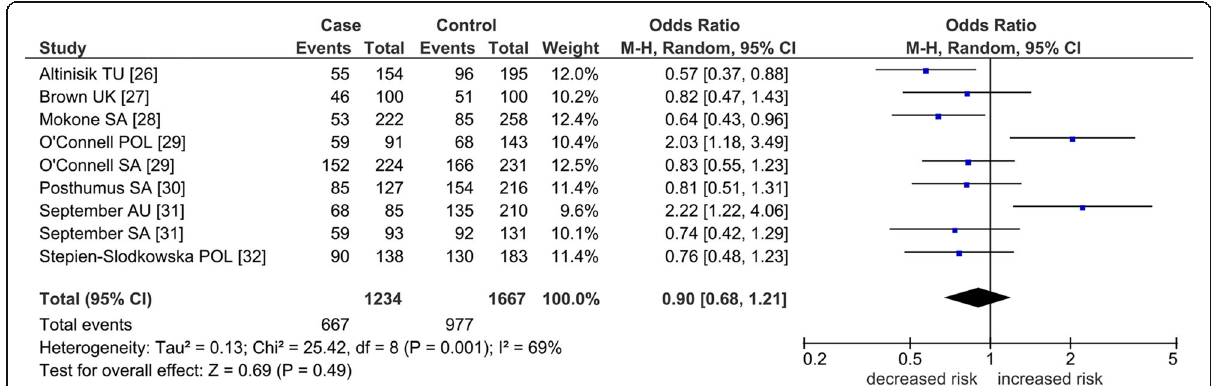
Fig. 2 Summary association of COL5A1 rs12722 polymorphism with TLI studies in the dominant model. Numbers in brackets under the study column indicate references. Squares indicate the odds ratio (OR) in each study, with square sizes directly proportional to the weight contribution (%) of the study. Horizontal lines on each side of the squares represent 95% confidence intervals (CIs). The random-effects model was used on account of the presence of heterogeneity ( p = 0.001, I 2 = 69%). M – H Mantel – Haenszel; df degree of freedom; TU Turkey; UK United Kingdom; POL